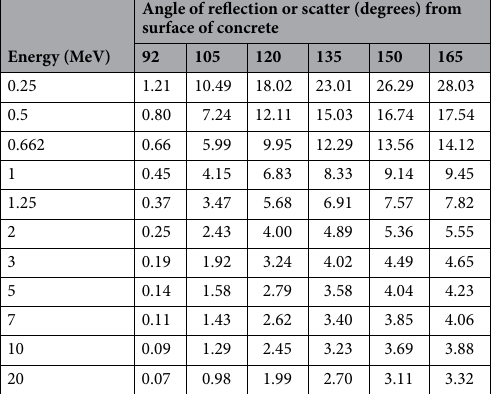
Table 1. The reflection coefficient of photons for ordinary concrete as a function of reflected angles calculated using the FLUKA code (wall-reflection coefficient). Multiply each table entry by 10 –3 (e.g., the entry 5.39 means 5.39 × 10 –3 ) with electrons cut-off = 100 keV and photons cut-off = 1 keV. The statistical uncertainties are within ± 4% (95% confidence limit).